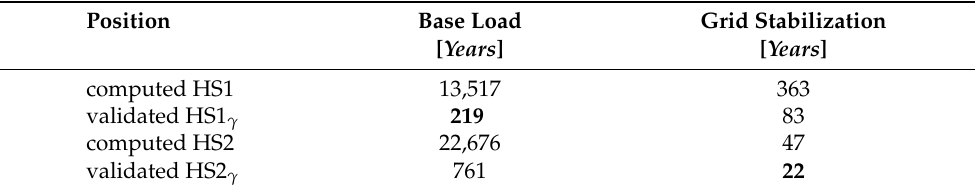
Table 4. Numerically estimated runner lifetime at different positions for scenarios base load and grid